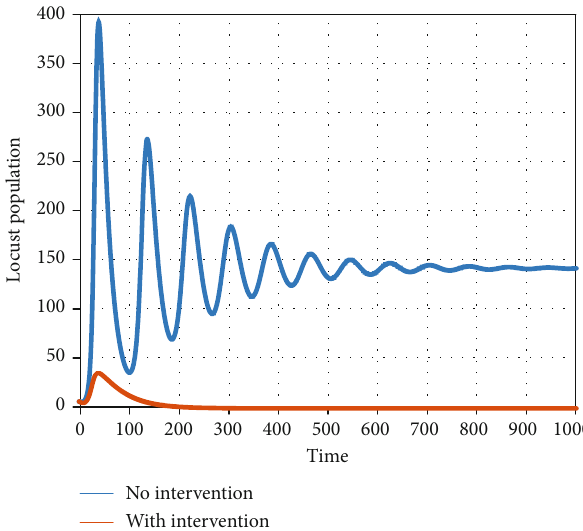
Figure 6: The impact of the proaction approach of early intervention on total locust populations. The simulation was conducted in the absence of intervention ( θ = θ within early intervention only on hopper bands ( θ = 0 : 0025 , θ = 0 : 00225 , and γ = 0 0 : 00025 , γ 1 2